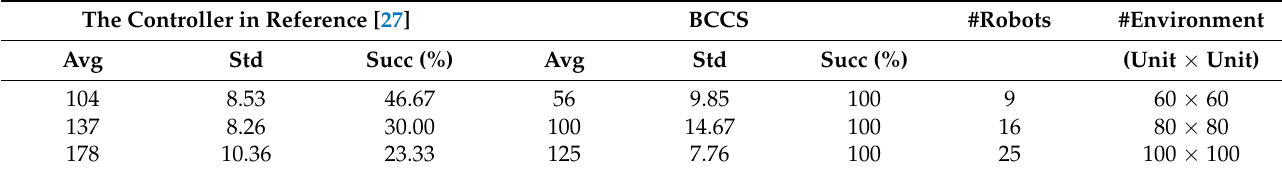
Table 5. Performance comparison